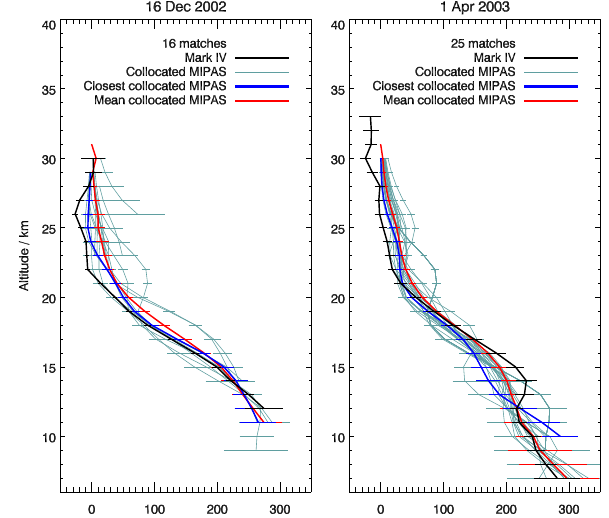
Figure 13. Two MkIV CFC-11 profiles are compared with collo- cated MIPAS profiles of the FR period. For the measurement on 16 December 2002, 16 collocated MIPAS measurements were found, while 25 MIPAS profiles coincided with the 1 April 2003 MkIV measurement. The setup is similar to Fig.